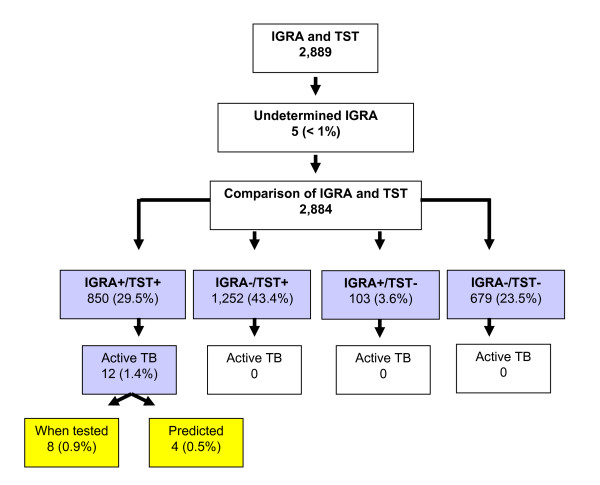
Flow chart of study population.